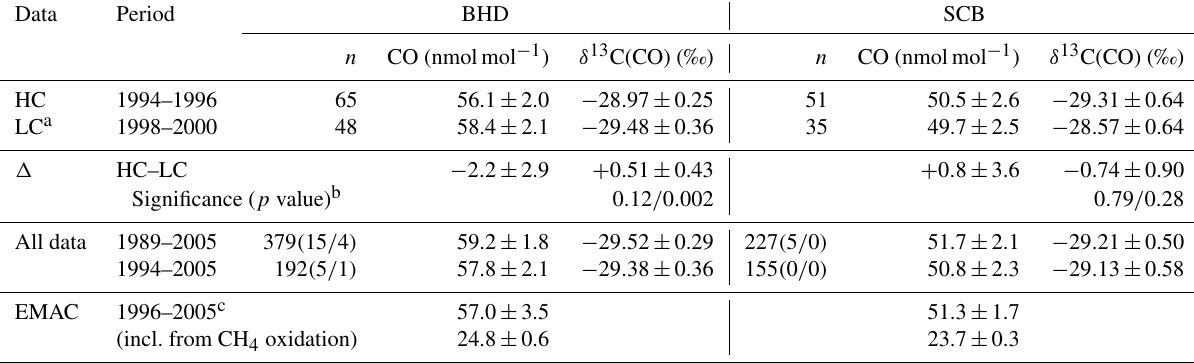
Table 1. Statistics on quasi-annual average (QAA) mixing and isotope ratios of CO observed and simulated at BHD and SCB. Data